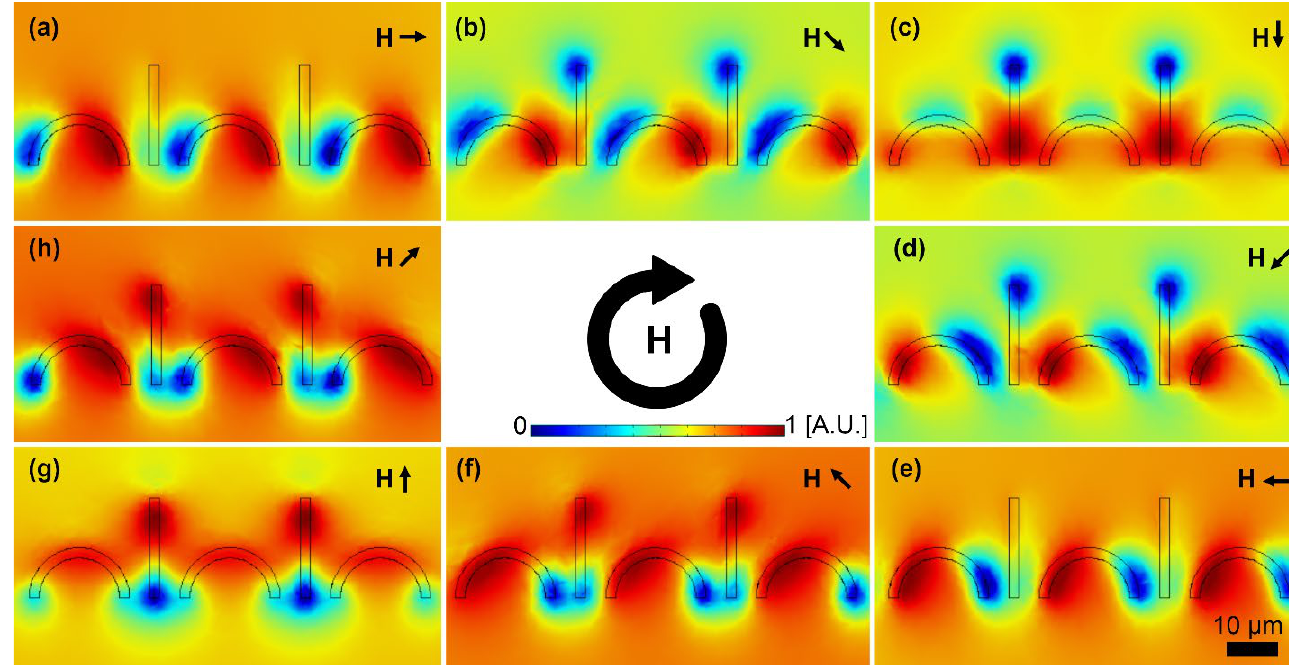
Figure 2. Magnetic energy simulation results for ( a ) a magnetic bar and ( b ) a magnetic disk exposed to an external in-plane magnetic field, and ( c , d ) after superimposing a vertical bias magnetic field perpendicular to the plane of the magnetic thin films are shown. The blue and red areas stand for the regions with low and high magnetic energies. The black arrows depict the magnetic field direction, and the little black dots represent the vertical bias field.